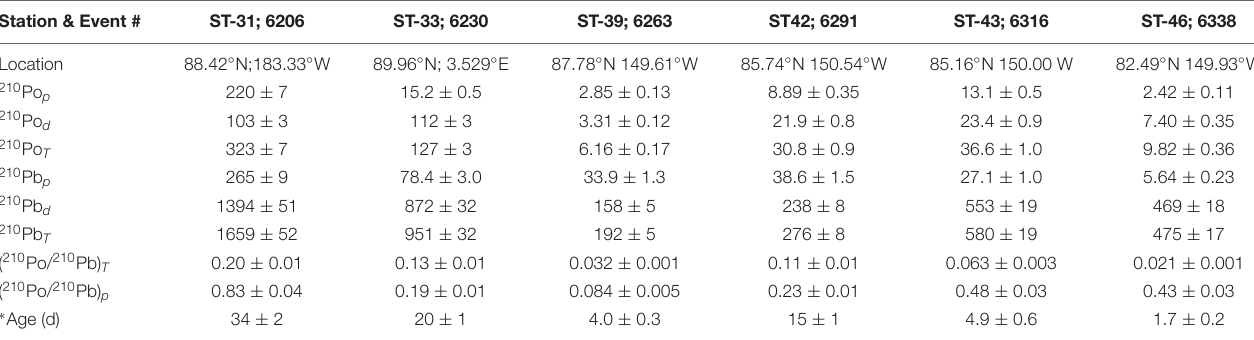
TABLE 3 | Activity of particulate (p), dissolved (d) and total (T) 210 Po and 210 Pb (in dpm 100L − 1 ), 210 Po/ 210 Pb activity ratio, and age of